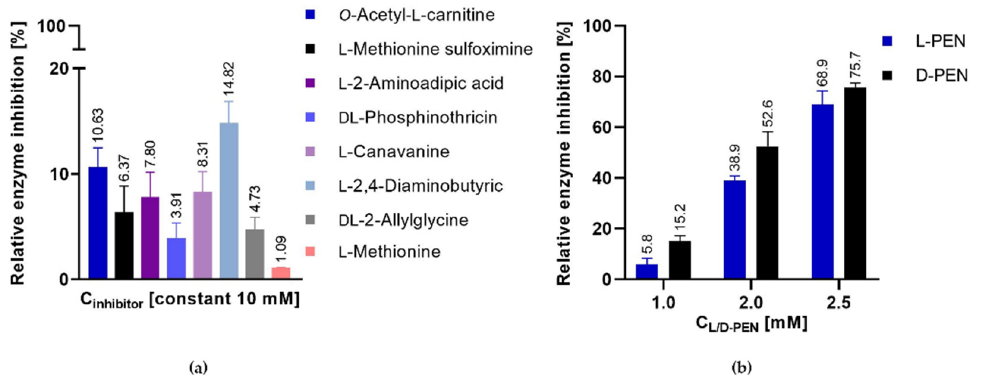
Figure 6. Relative Ca Met2NHp inhibition by: ( a )commercially available Hom analogs and L-Met, 10 mM; ( b ) by L-Pen or D-Pen at 1.0, 2.0, or 2.5 mM concentrations. Data shown are the means of at least three independent experiments ±SD.